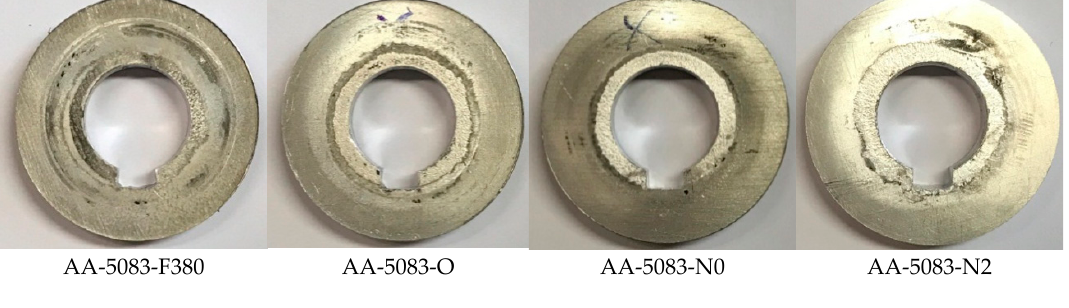
( b ) Figure 11. Disk after the wear experimental test ( a ) and final volume loss ( b ). 𝑉 (cid:3036)(cid:3041)(cid:3036)(cid:3047) − 𝑉 (cid:3033) 𝛱 ⋅ 𝐷 ⋅ 𝑤 = 𝑤𝑒𝑎𝑟